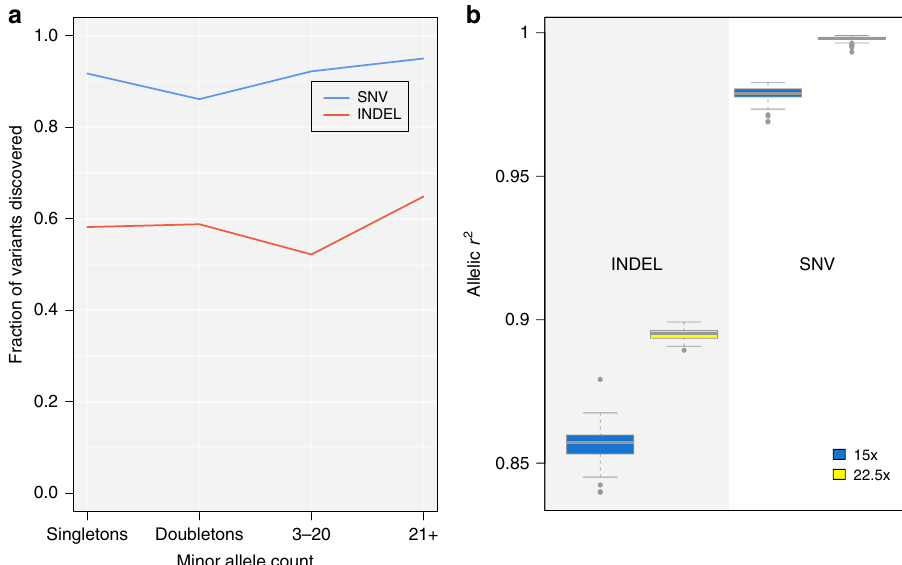
Fig. 1 Variant discovery and quality in WGS data from 100 samples. a variant discovery rate in 22.5×; b allelic r 2 for SNVs and INDELs in both 15× and 22.5× calls. Depth is downsampled randomly from 30×. INDEL: insertion/deletion. SNV: single nucleotide variant. Boxes represent the interquartile range. Bold horizontal lines in boxplots represent the median, the whiskers extend to 1.5 times the interquartile range, and grey dots represent outliers outside the whisker